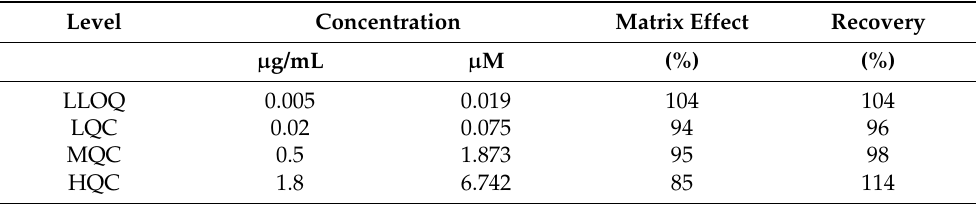
Table 1. Recovery and matrix effect (ME%) of adenosine in blood samples at four concentration levels. Extraction was performed three times and analysis in